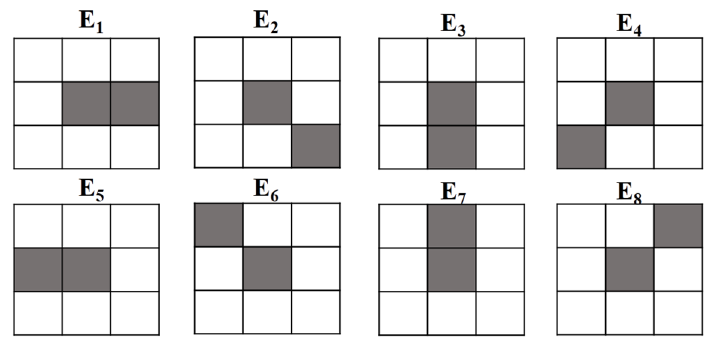
Figure 6. Eight structural elements used in the microstructure image.